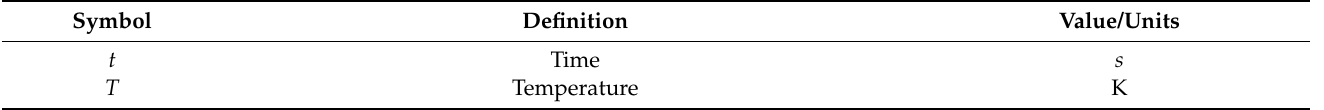
Table A1. Complete list of